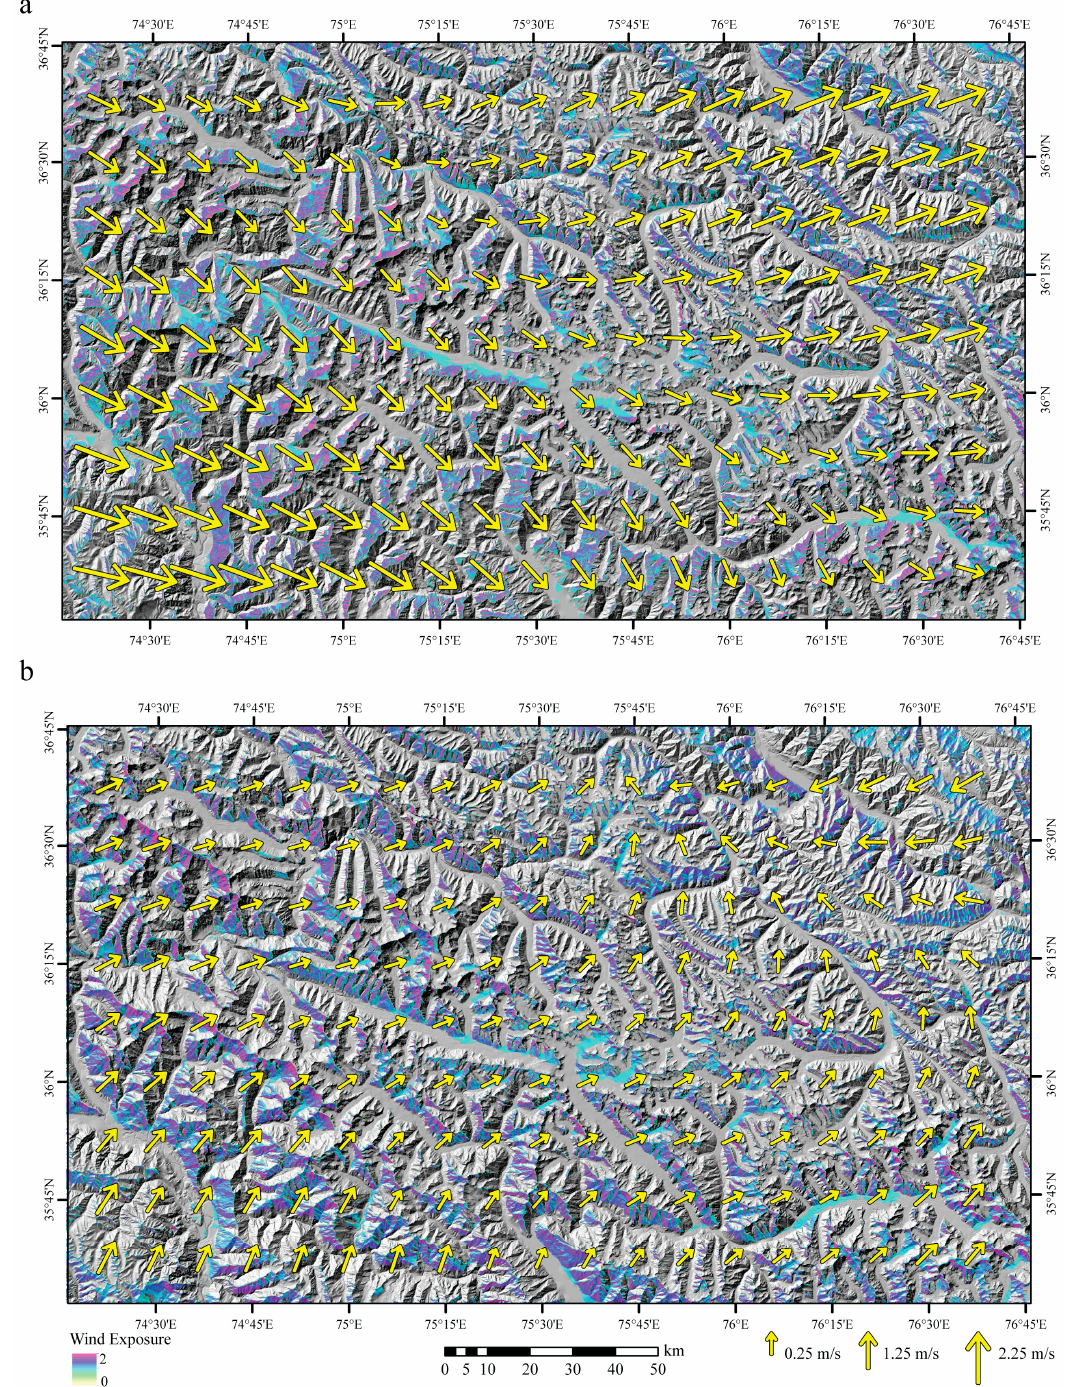
Figure 3. Terrain windward exposure (a unitless index) of the Westerlies in the Central Karakoram in: March ( a ); and August 2013 ( b ). Demonstrated are variable wind directions across the Karakoram coupled with the anisotropic nature of the topography generating variability in orographic precipitation patterns.